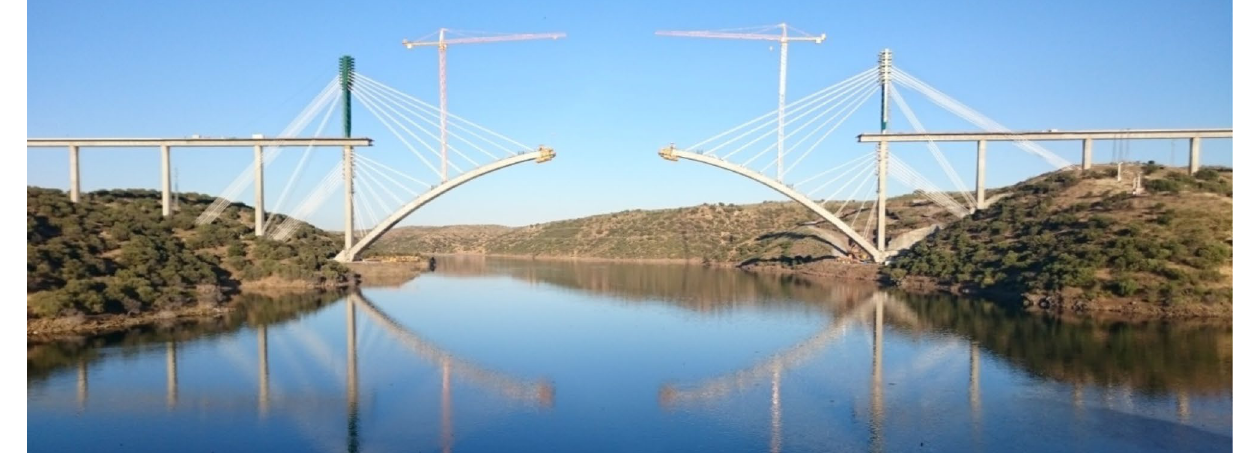
Figure 1. Tajo River Viaduct during its construction.